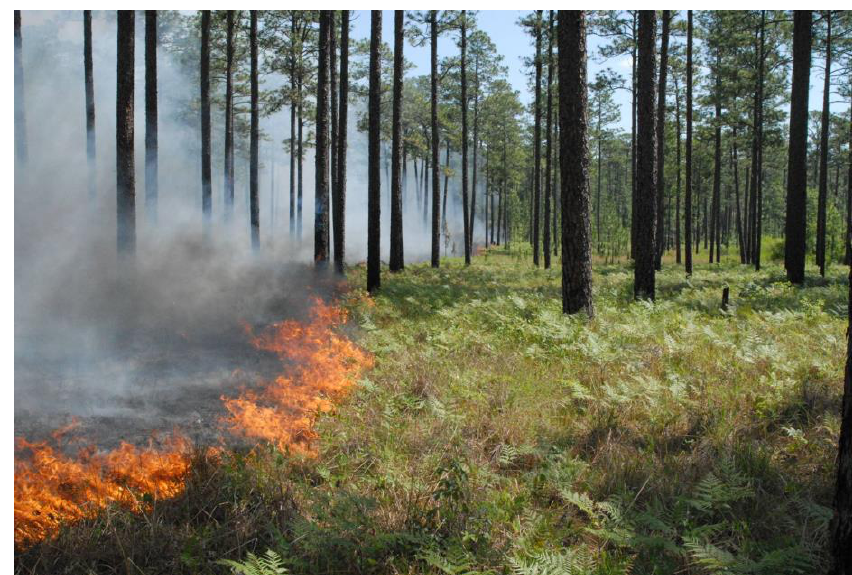
Figure 5. Prescribed fire of longleaf pine ecosystem (photograph by Dale Brockway, USDA Forest Service).